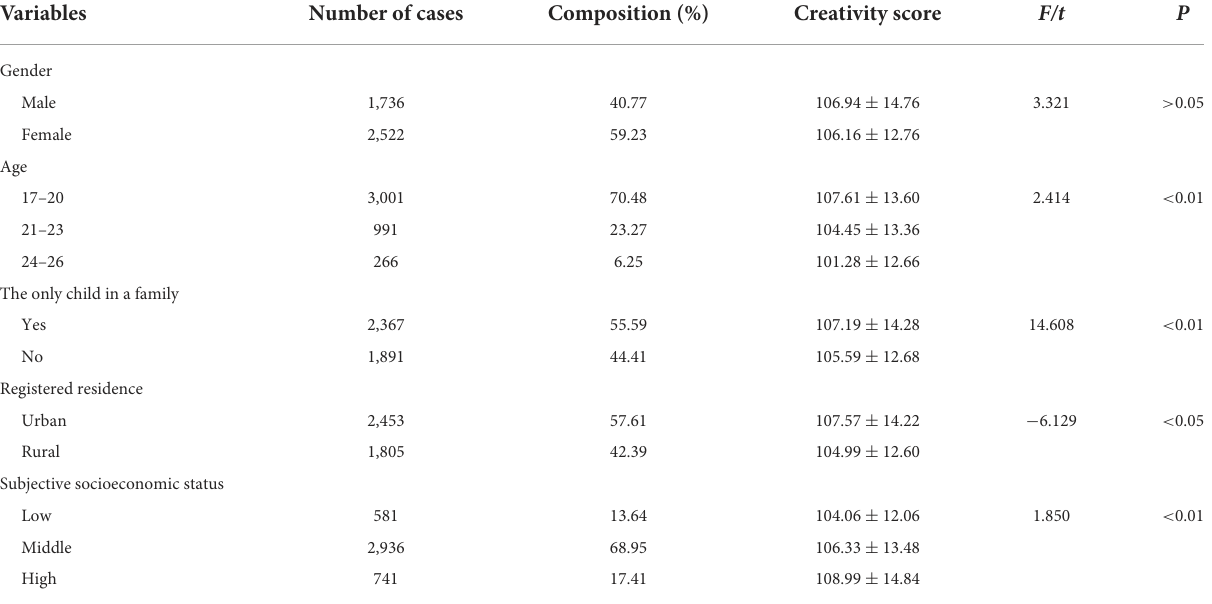
TABLE 1 Basic situation and creativity score of college